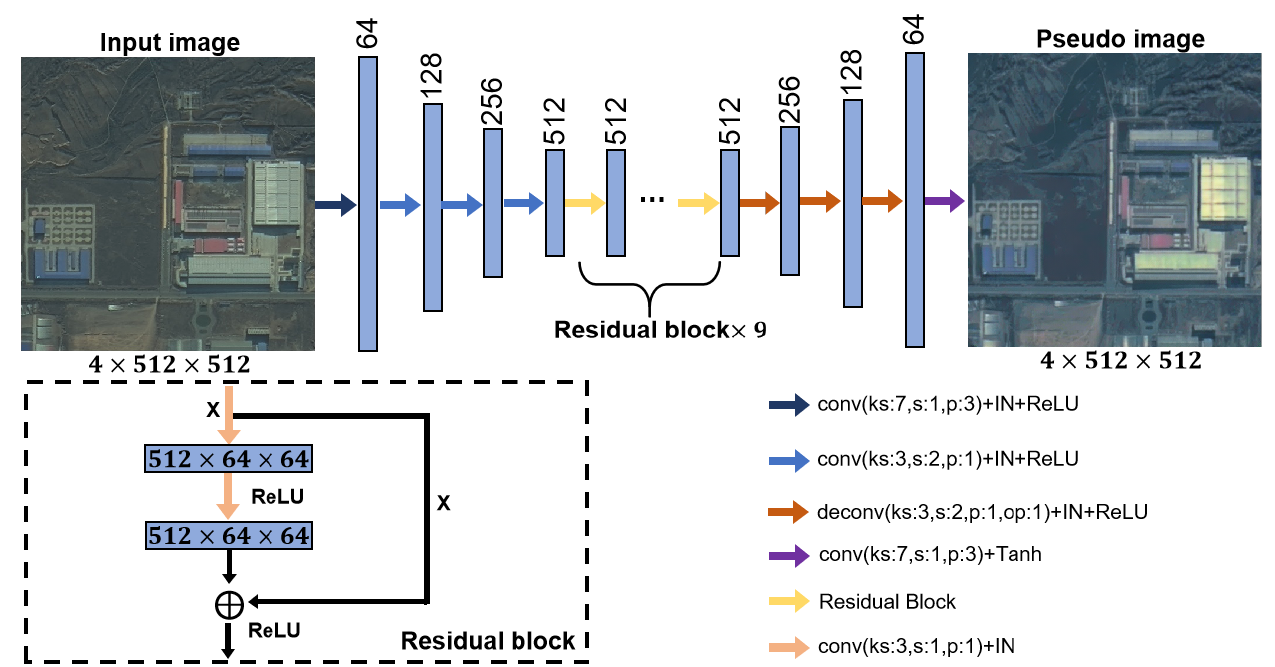
Figure 5. The architecture of the generator. ks, s, p and op correspond to kernel size, stride, padding and output padding parameters of the convolution and deconvolution respectively. ReLU and IN stand for rectified linear unit and instance normalization. The generator uses nine residual blocks.